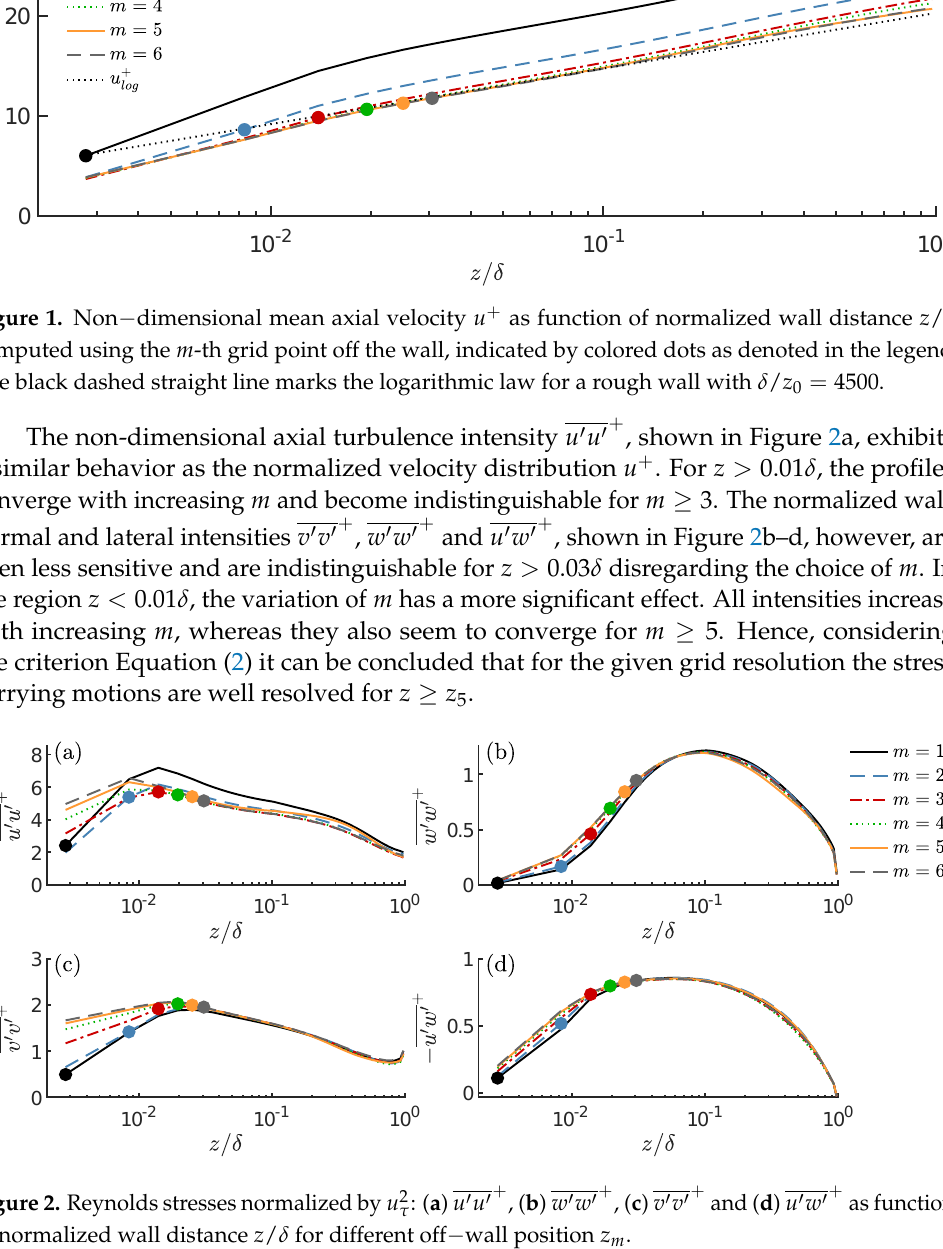
Figure 2. Reynolds stresses normalized by u 2 τ : ( a ) u (cid:48) u (cid:48) of normalized wall distance z / δ for different off − wall position z m